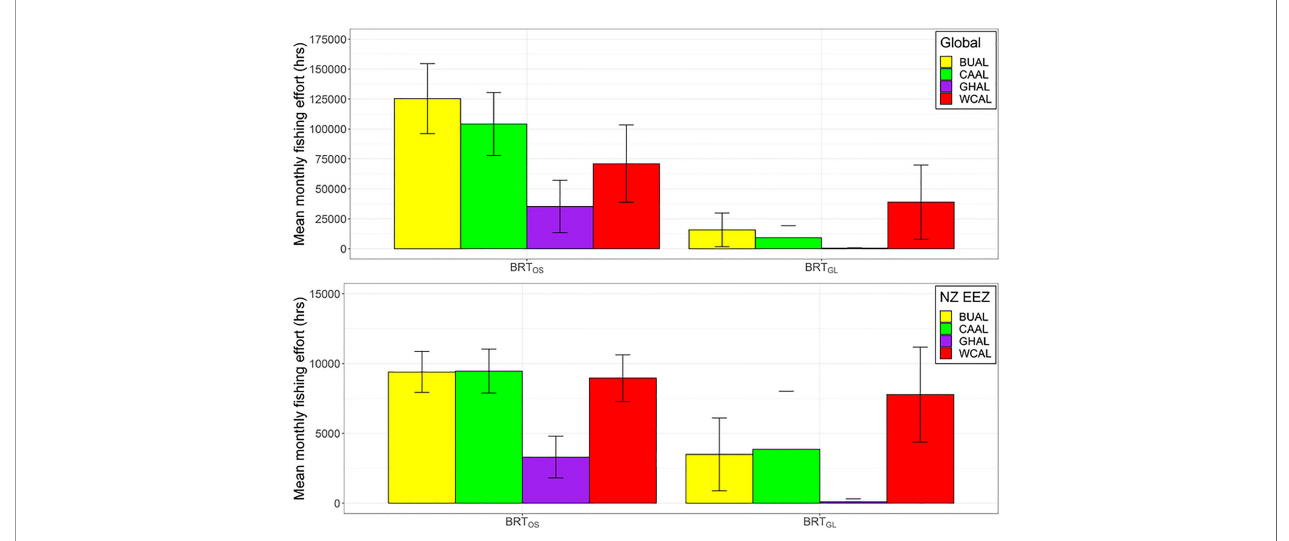
FIGURE 6 | Mean monthly fi shing effort (hrs) (based on data from Global Fishing Watch) that occurs within the preferred habitat of four albatross species both globally (top) and within New Zealand ’ s Exclusive Economic Zone (bottom) for two BRT models (one fi t with opportunistic sightings data [BRT OS , left], and one fi t with geolocation data [BRT GL , right]. Colour coding denotes different albatross species and error bars indicate one standard